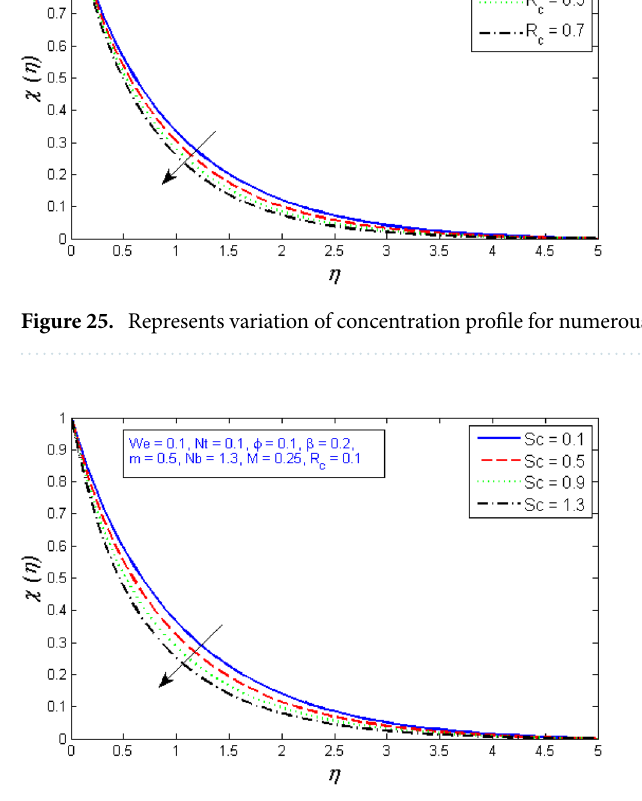
Figure 26. Represents variation of concentration profile for several number of Schmidt number Sc .